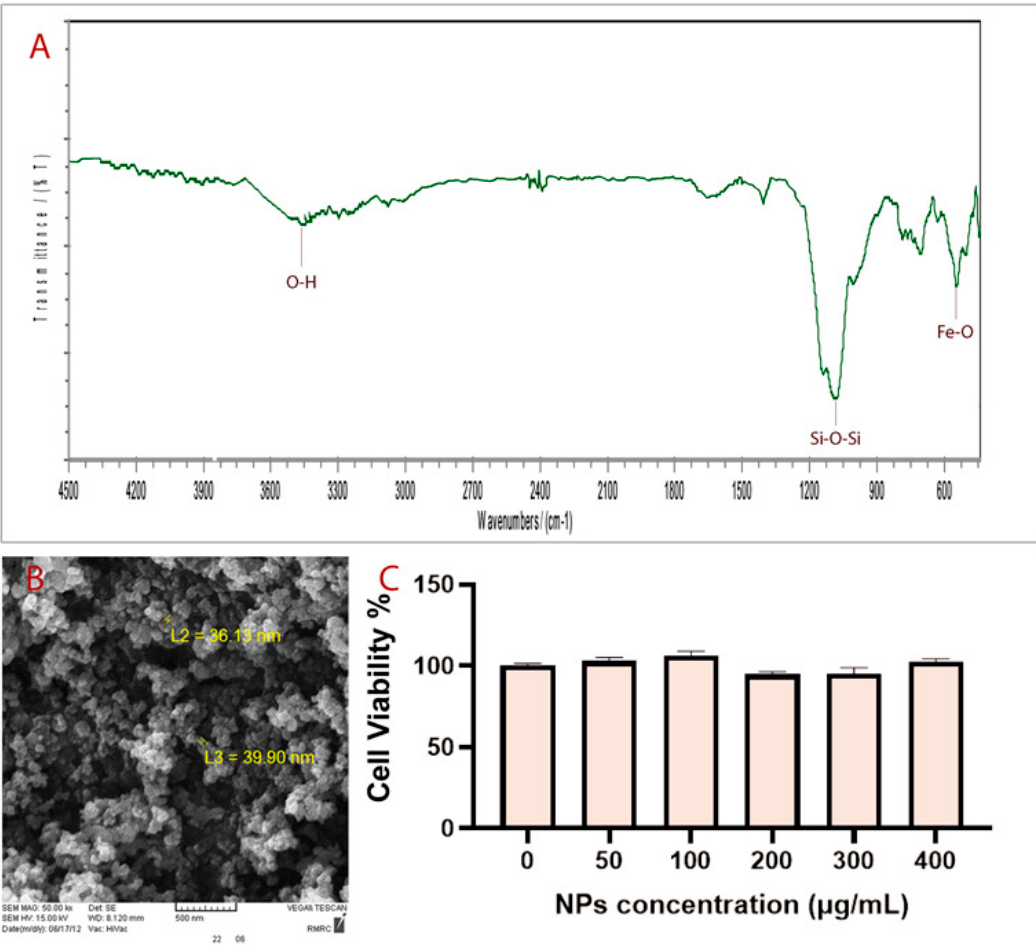
Figure 1. ( A ) FT-IR spectrum, ( B ) SEM image, and ( C ) MTT analysis.